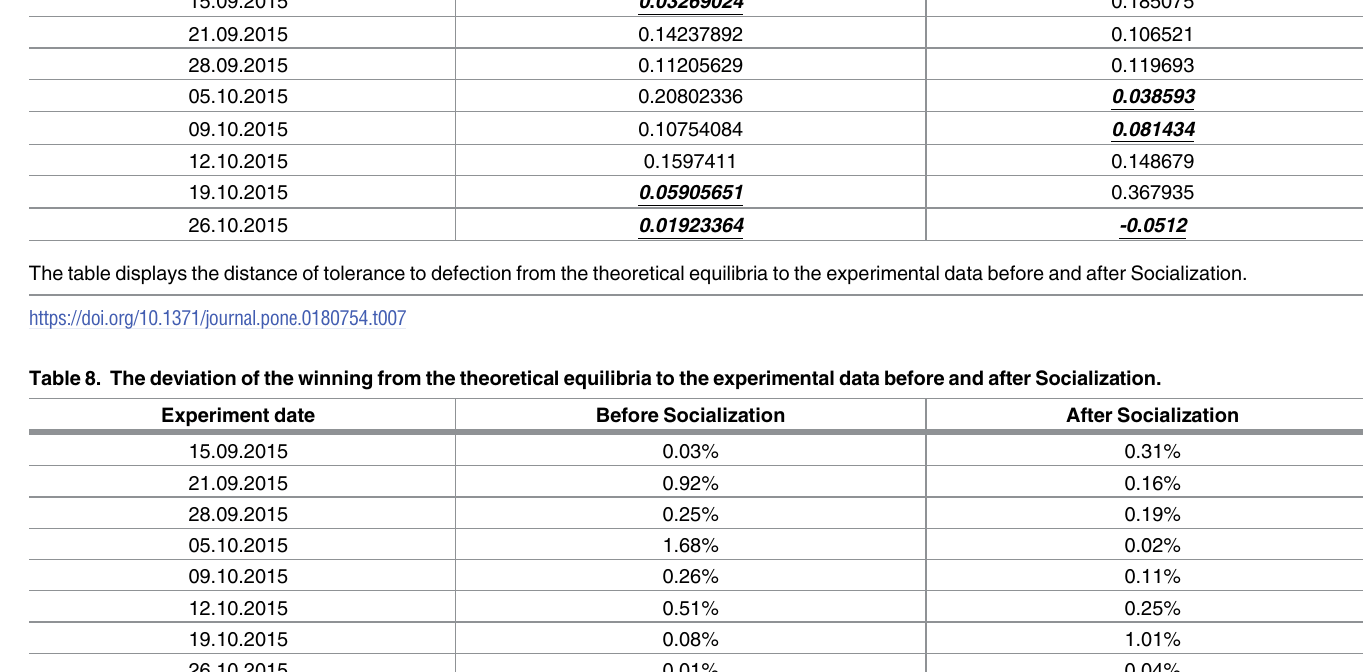
Table 7. The distance of tolerance to defection from the theoretical equilibria to the experimental data before and after Socialization. Experiment date